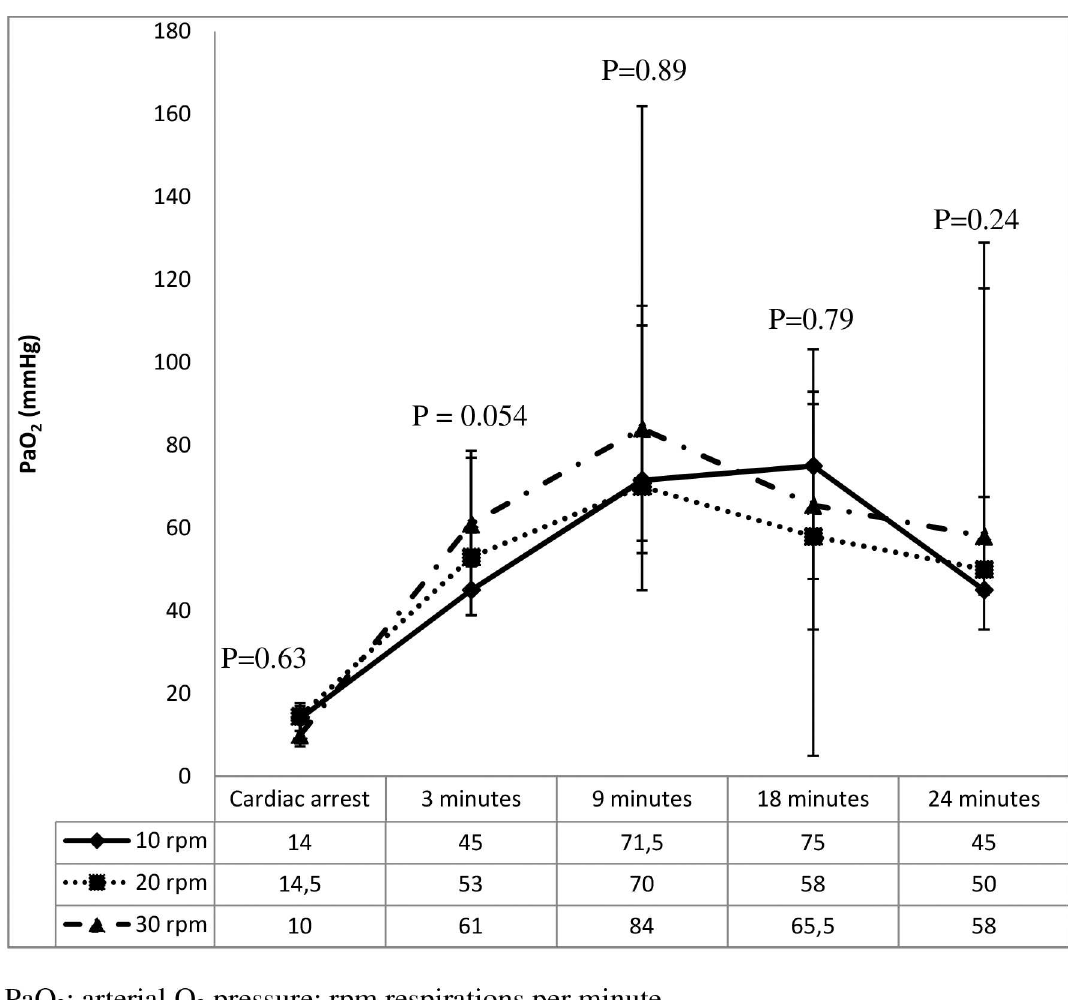
Fig 3. ArterialPO 2 values (mmHg) duringresuscitation.